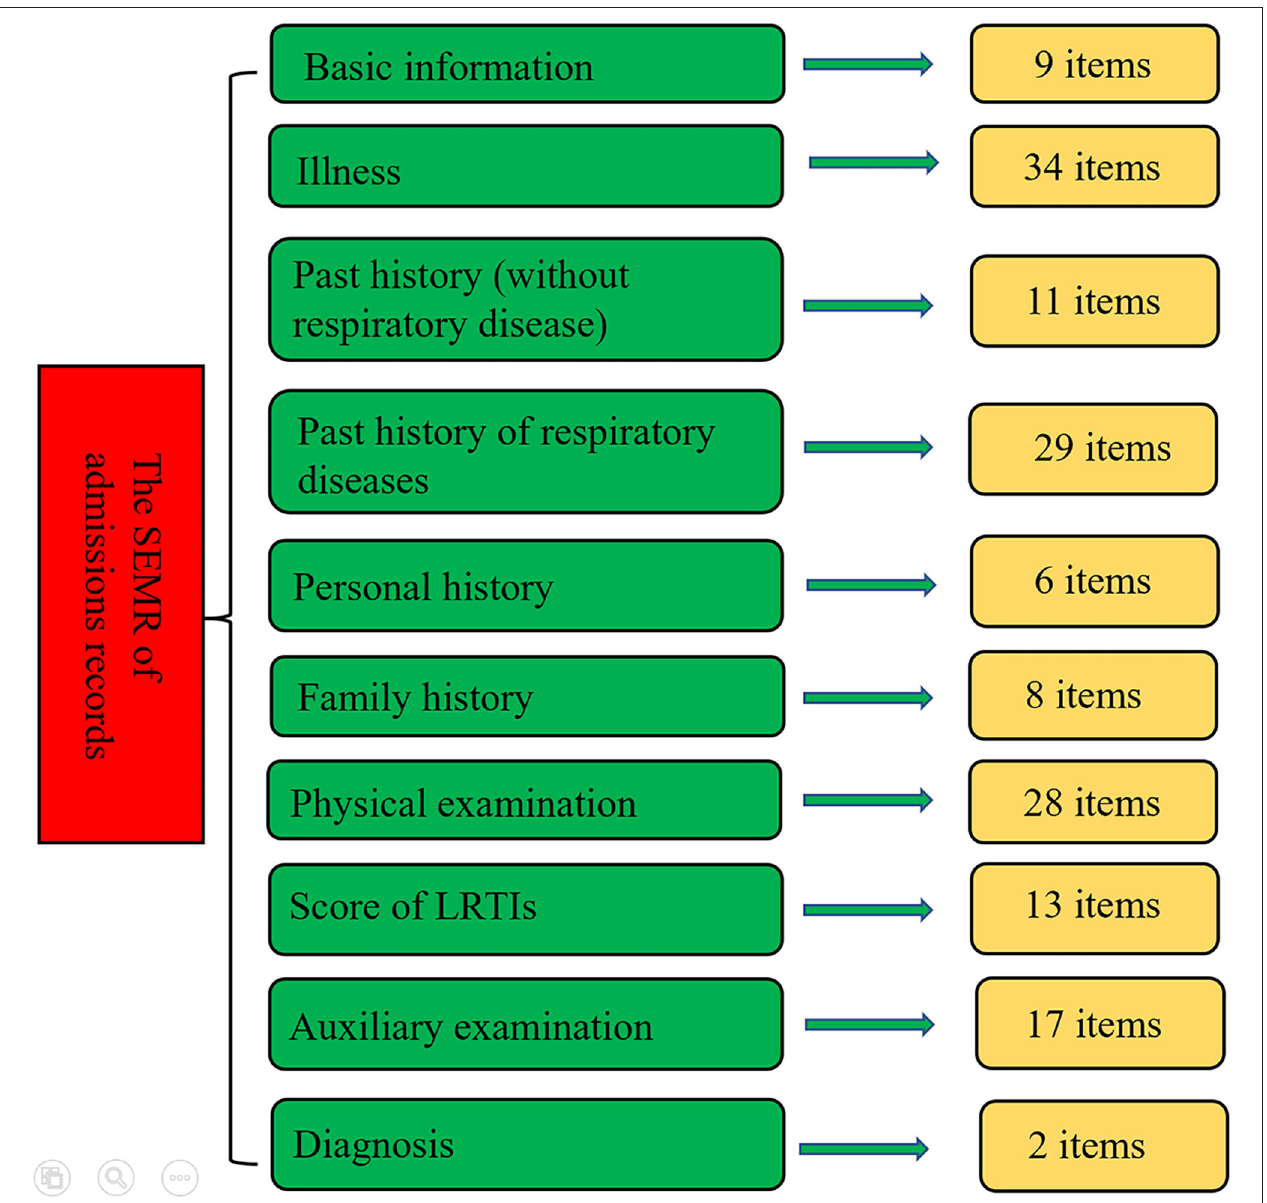
FIGURE 1 | The outline of the structured electronic medical record (SEMR) of admission